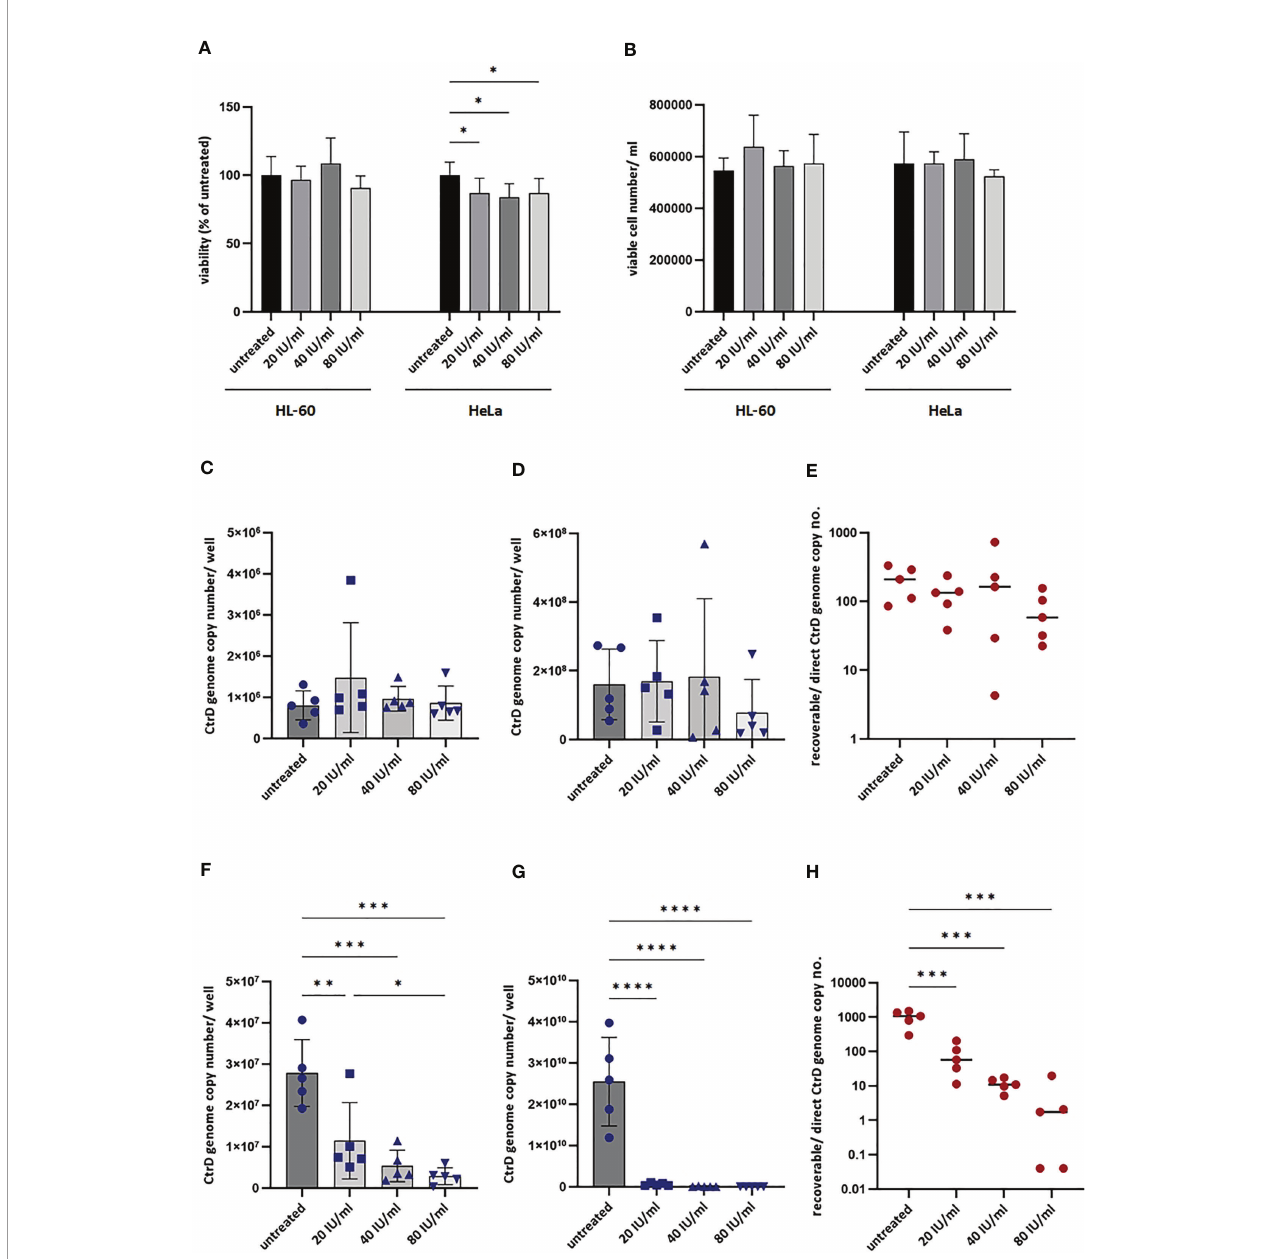
FIGURE 6 | Impact of interferon-gamma (IFNG) on the growth of Chlamydia trachomatis in HL-60 and HeLa cells. (A) Impact of IFNG on the viability of HL-60 and HeLa cells. MTT cell viability assay of HL-60 and HeLa cells incubated with 0 – 20 – 40 – 80 IU/ml IFNG for 24 h. Data are mean±SD ( n =8). (B) Viable cell counting of HL-60 and HeLa cells incubated with 0 – 20 – 40 – 80 IU/ml IFNG for 24 h. Data are mean±SD ( n =4). To quantify C. trachomatis growth, HL-60 and HeLa cells were infected with C. trachomatis (multiplicity of infection, 4) and treated with 20 – 40 – 80 IU/ml IFNG. To measure direct chlamydial growth, HL-60 and HeLa cells ( n = 5) were lysed at 48 h post-infection, and the chlamydial genome concentrations were measured by direct qPCR. For recoverable growth measurement, cell lysates from the direct growth measurements were used to infect McCoy cells. Chlamydial growth was measured by direct qPCR at 48 h post-infection. (C) Direct chlamydial growth in HL-60 cells. (D) Recoverable chlamydial growth in HL-60 cells. (E) Comparison of chlamydial genome concentration in recoverable vs . direct growth HL-60 samples. (F) Direct chlamydial growth in HeLa cells. (G) Recoverable chlamydial growth in HeLa cells. (H) Comparison of chlamydial genome concentration in recoverable vs . direct growth HeLa samples. For (C, D, F, G) , data are mean±SD, and individual values are also shown ( n =5). For (E, H) , the mean and individual values are shown ( n = 5). One-way ANOVA with correction for multiple testing was used for statistical analysis. * P < 0.033, ** P < 0.002, *** P < 0.001, **** P <